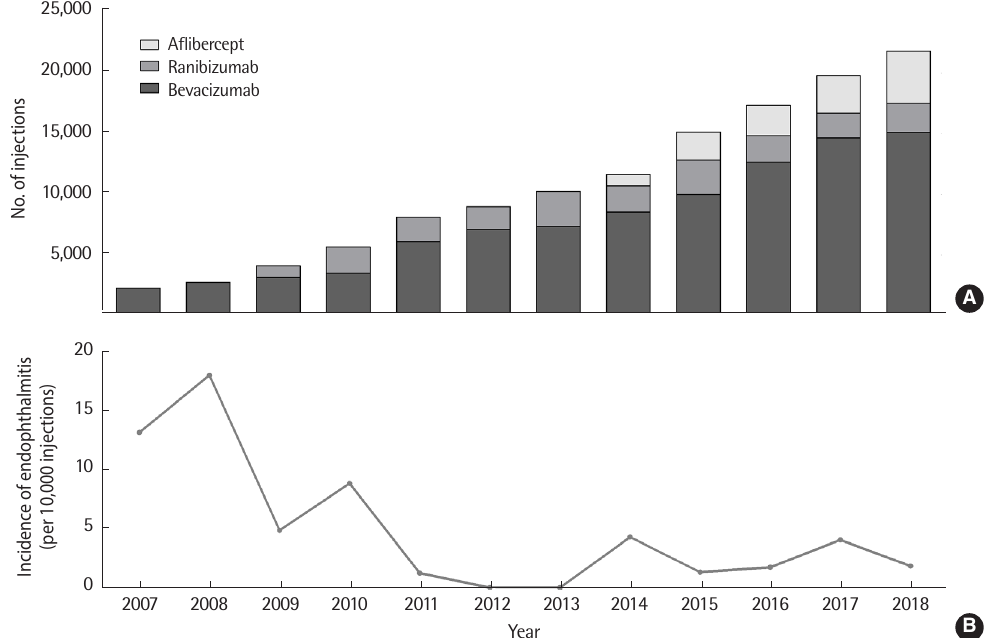
Figure 2. The number of anti-vascular endothelial growth factor injections (A) and incidence of endophthalmitis (B) in each year from 2007 to